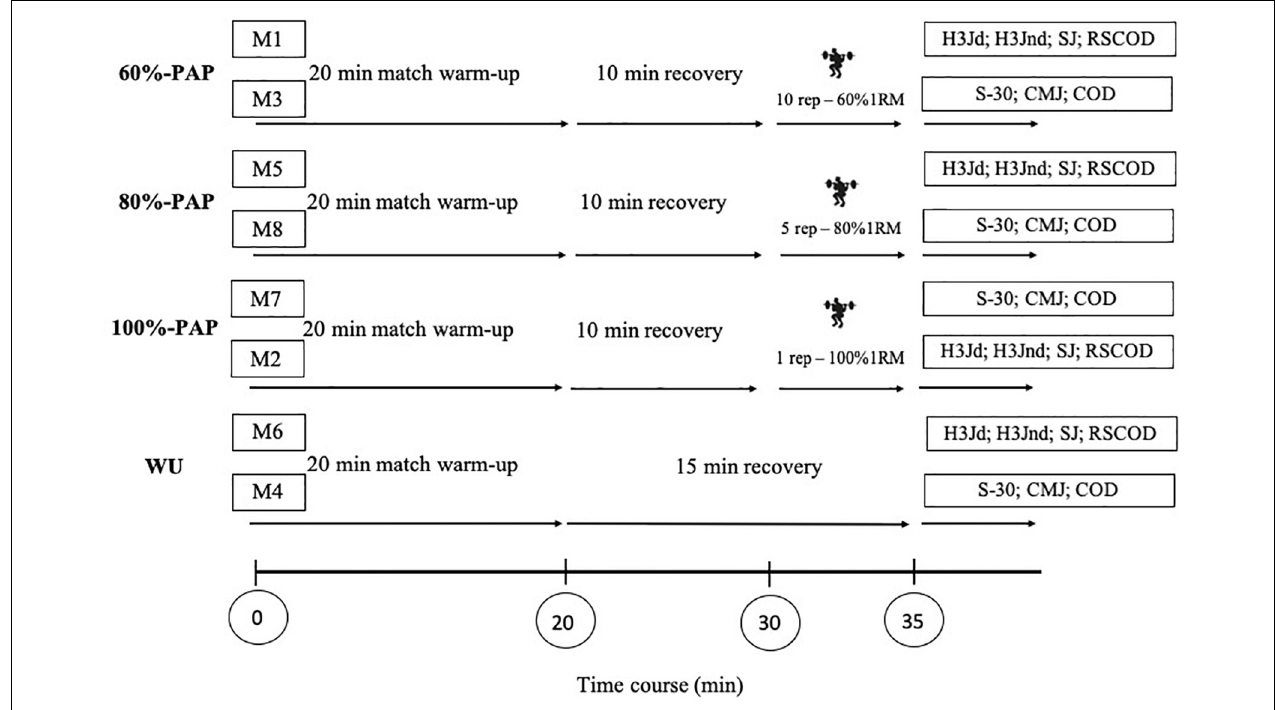
FIGURE 2 | Overview of the cross-over experimental design, indicating the control and three different warm-up conditions. The 15-minutes recovery period was included during control condition. The 10-minutes plus 5-minutes recovery period were included during PAP protocols, to simulate match conditions. The tests were divided at two measurement (M) day corresponding to each protocols. 60%-1RM, 80%-1RM, and 100%-1RM refer to match warm-up post-activation potentiation (PAP) protocols at 60, 80 and 100% of 1RM, respectively; WU, match warm-up protocol; M, measurement; H3Jd, triple hop test with dominant leg; H3Jnd, triple hop test with non-dominant leg; SJ, squat jump test; RSCOD, repeated sprint with change of direction test; S-30, linear 30-m sprint test; CMJ, countermovement jump test; COD, change of direction ability test.